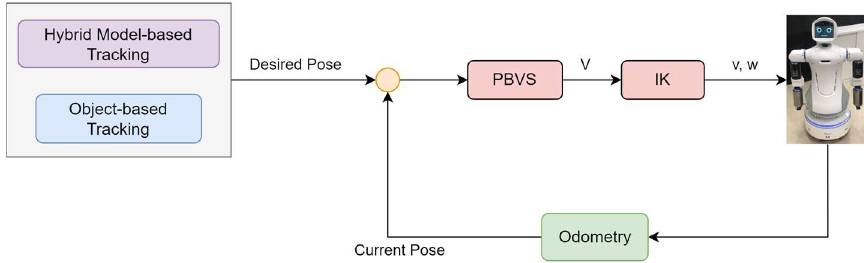
Figure 11. Block diagram of the visual-servo control for the arms. Algorithm 3 Pseudocode of the visual-servo control of the robotic arms While (true)